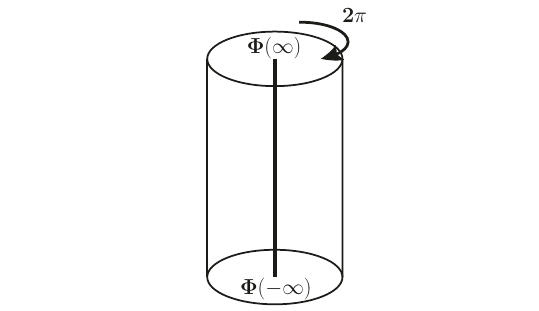
Figure 1 . CFT at (cid:12)nite temperature (cid:12) (cid:0) 1 with heavy operators at spatial in(cid:12)nity.